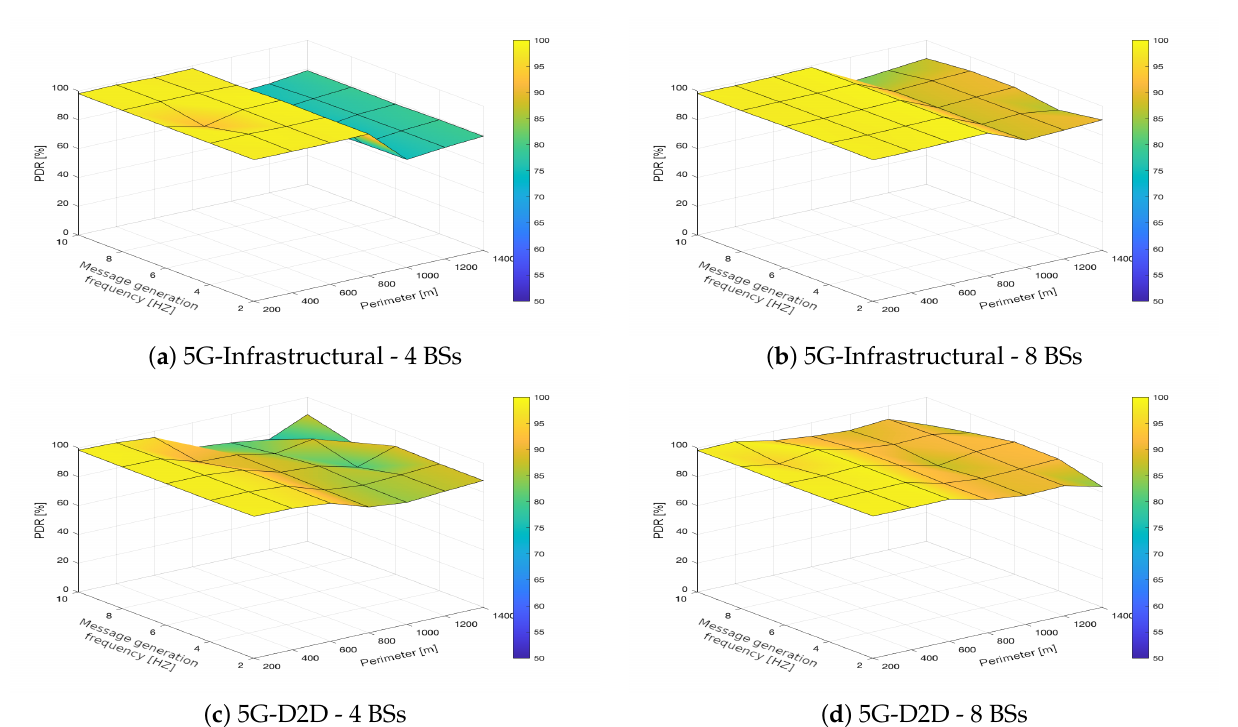
Figure 16. PDR simulated for the both modes of the 5G-based C-V2X technology, both infrastructure density deployments and traffic intensity of 250 vehicles per